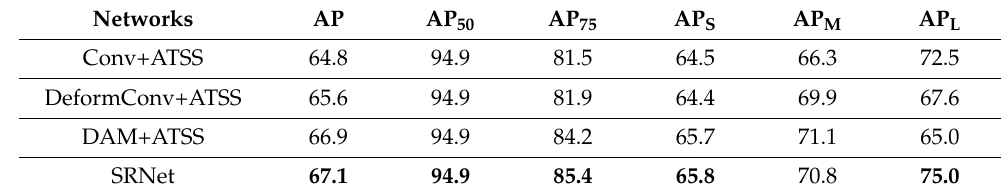
Table 5. Ablation experiment results of our network framework on the SSDD dataset.